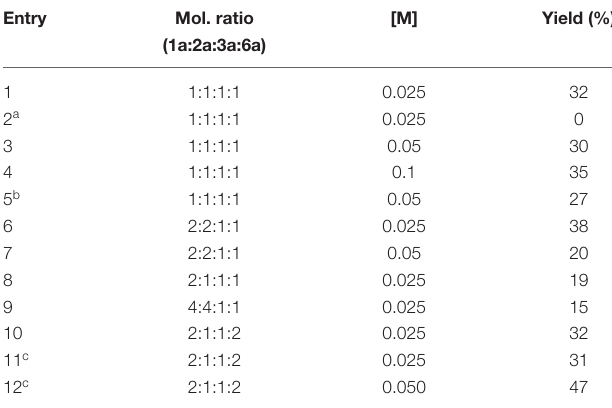
TABLE 1 | Optimization of the synthesis of 2,3-dihydro-4-nitropyrrole 7a .*